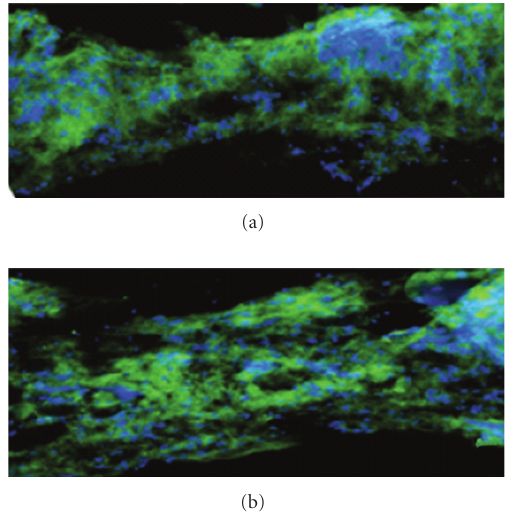
Figure 14: Immunofluorescence image of the regenerated nerve inside the hydrogel tube at 30 (a) and 90 (b) days after surgery [64].